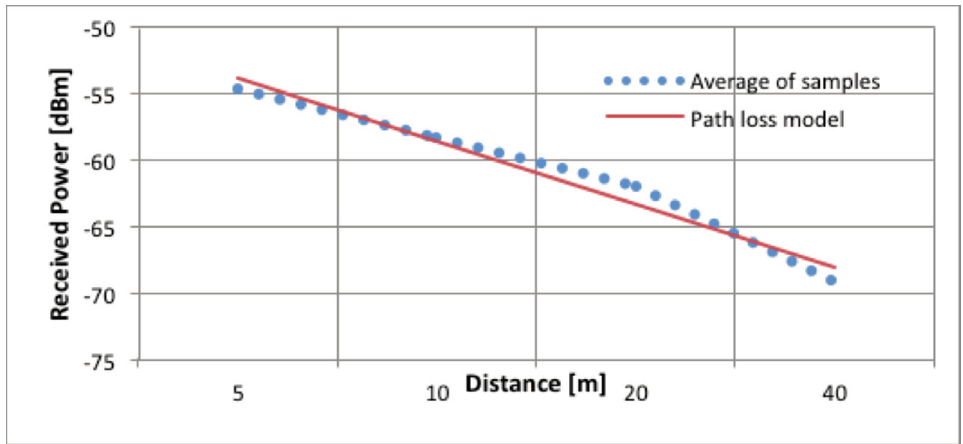
Figure 9. Sampled signal strength values for channel